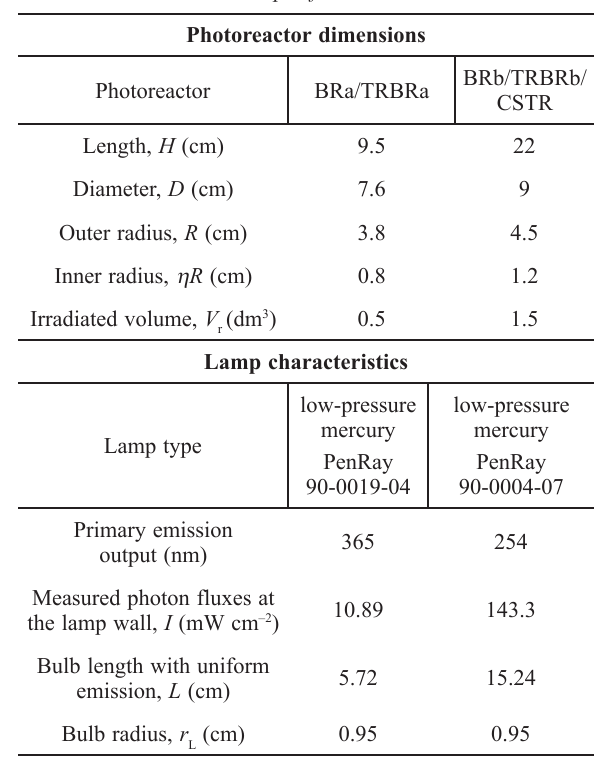
Table 1 – Photoreactors